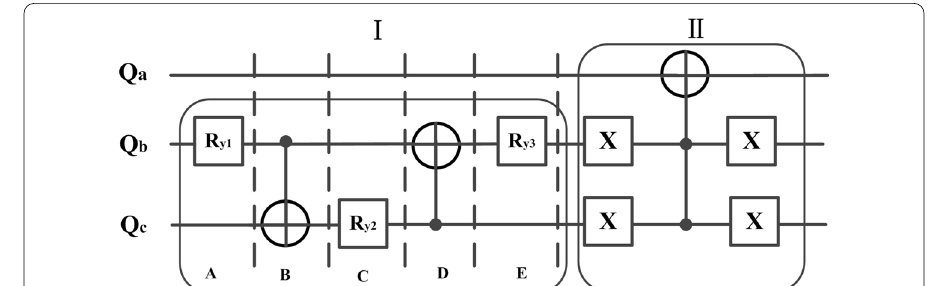
Fig. 5 The quantum circuit for preparation of three-particle W-state quantum